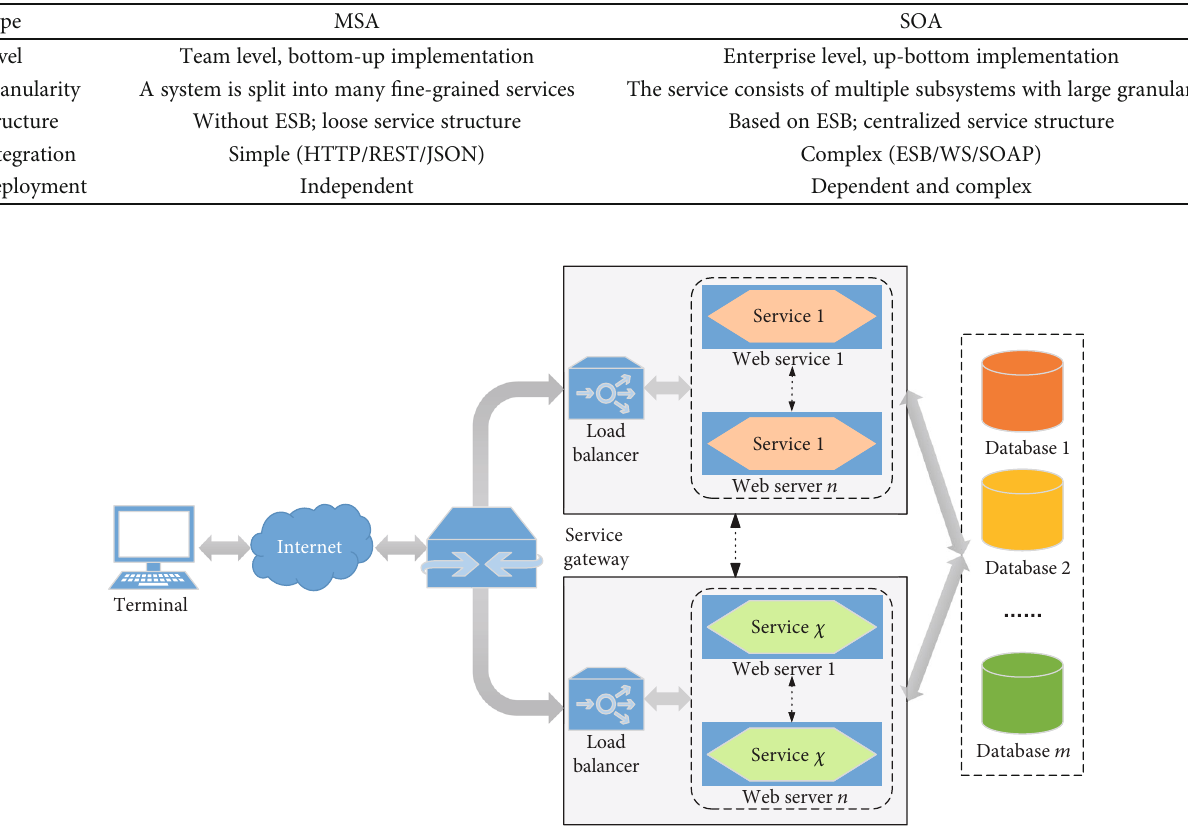
Figure 1: MSA deployment method. The multiple instances wherein each microservice can be deployed on di ff erent web servers (e.g., the instances service X can be deployed in Web server 1, … , Web server n ,